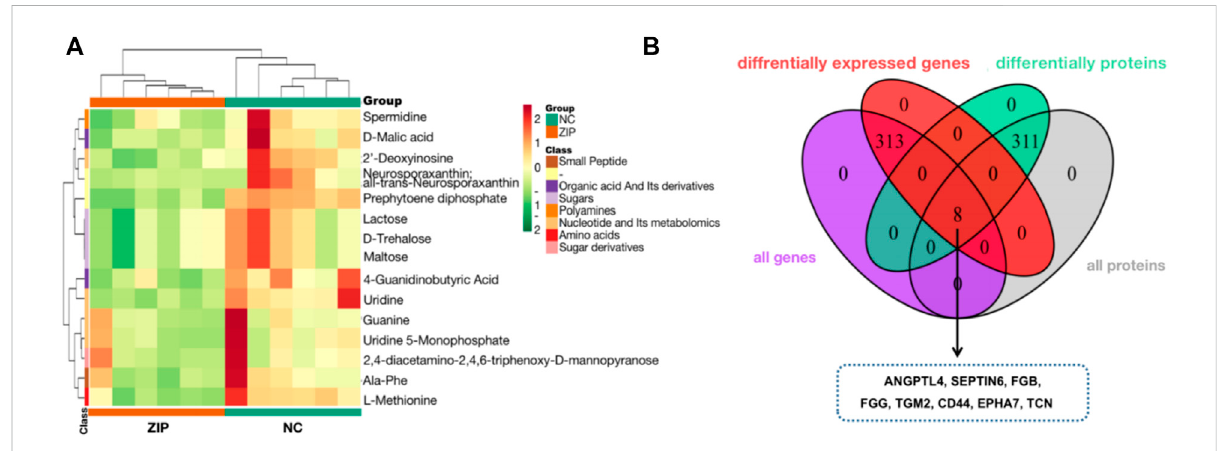
FIGURE 4 Metabolic analysis and Integrated analysis of SLC39A1-Overexpressed OSRC-2 cells. (A) Metabolites cluster analysis based on KEGG enrichment analysis result. (B) 8 genes have changes at both the transcriptional and protein levels.